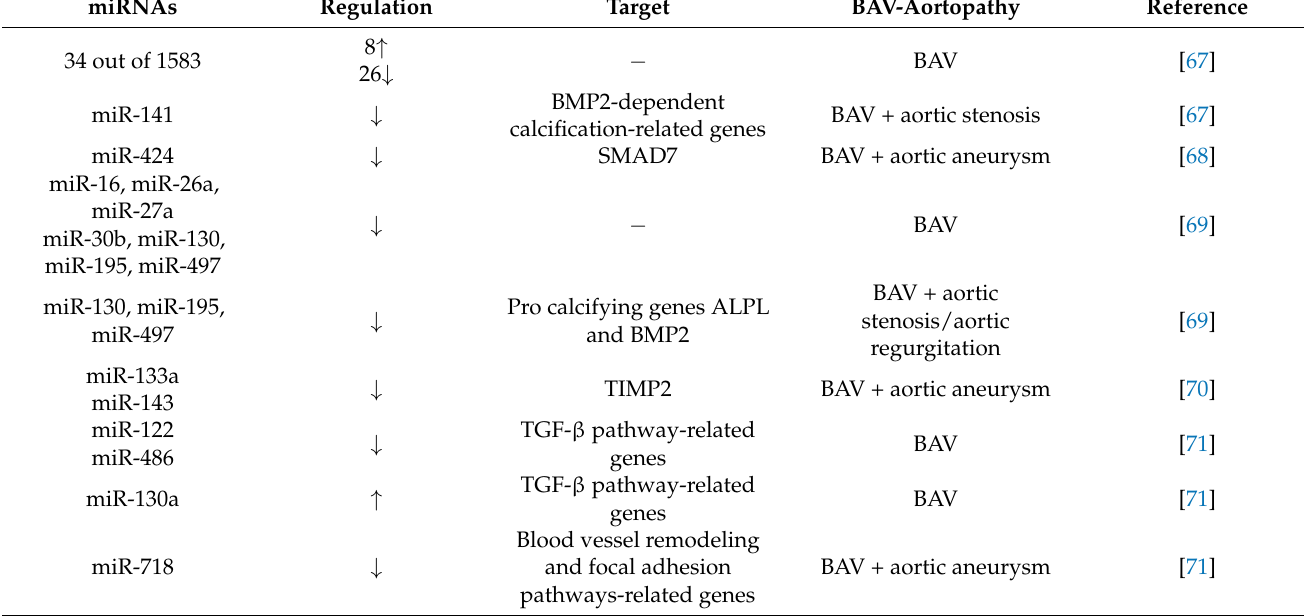
Table 2. MicroRNAs with differential expression in BAV patients or BAV-associated aortopathies. miRNAs Regulation Target